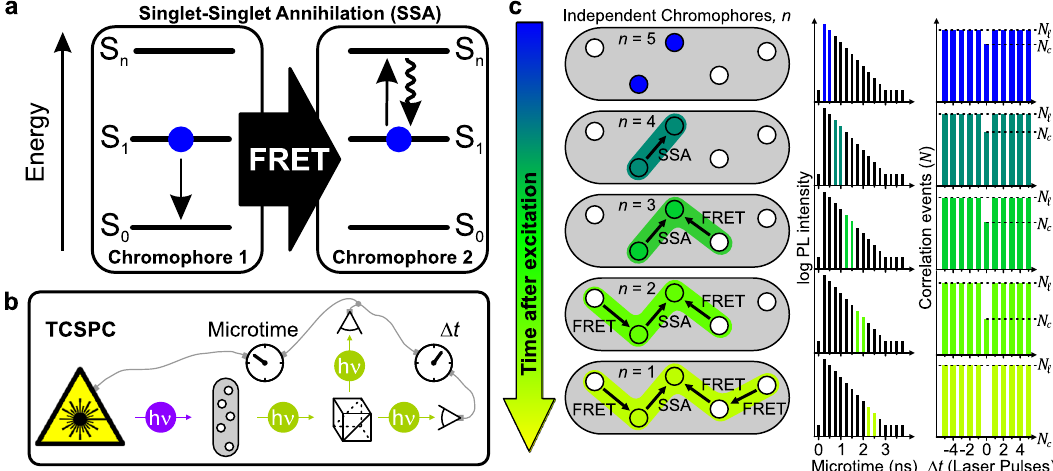
Fig. 1 Picosecond time-resolved antibunching (psTRAB). a Singlet – singlet annihilation (SSA) of a singlet exciton, S 1 , on chromophore 1 by Förster resonance energy transfer (FRET) to an exciton on chromophore 2, which excites it into a higher excited state, S n . Subsequently, chromophore 2 relaxes by internal conversion into its fi rst excited state, S 1 . Thus, the exciton (blue dot) on chromophore 1 is annihilated. b Principle of time-correlated single-photon counting (TCSPC) combined with a Hanbury Brown and Twiss photon correlator. A pulsed laser (purple) excites a multichromophoric nanoparticle (mcNP) (grey area). The statistics of the PL photon stream (green) are analysed by cross-correlating the signal of two photon detectors. TCSPC yields the time difference between excitation and emission events, i.e. the “ microtime ” , and the time difference between consecutive emitted photons, Δ t , as determined by the repetition period of the pulsed laser. c On the left, fi ve chromophores (discs) in an mcNP are shown schematically with two singlet excitons (coloured discs), which after excitation can diffuse by site-to-site hopping, i.e. by homo-FRET and annihilate by SSA as a function of the excited-state lifetime. The overall PL decay, constructed from the microtimes, is shown in the centre, with the corresponding binned arrival time windows of photons used to construct the antibunching histograms stated in the right-hand column. The ratio, N c = N ‘ , of the number of correlation events in the central peak at Δ t = 0, N N ℓ , allows us to determine the number of independent chromophores, n . As excitons diffuse c , versus those in the lateral time-lagged peaks, through homo-FRET and annihilate through SSA, n drops with